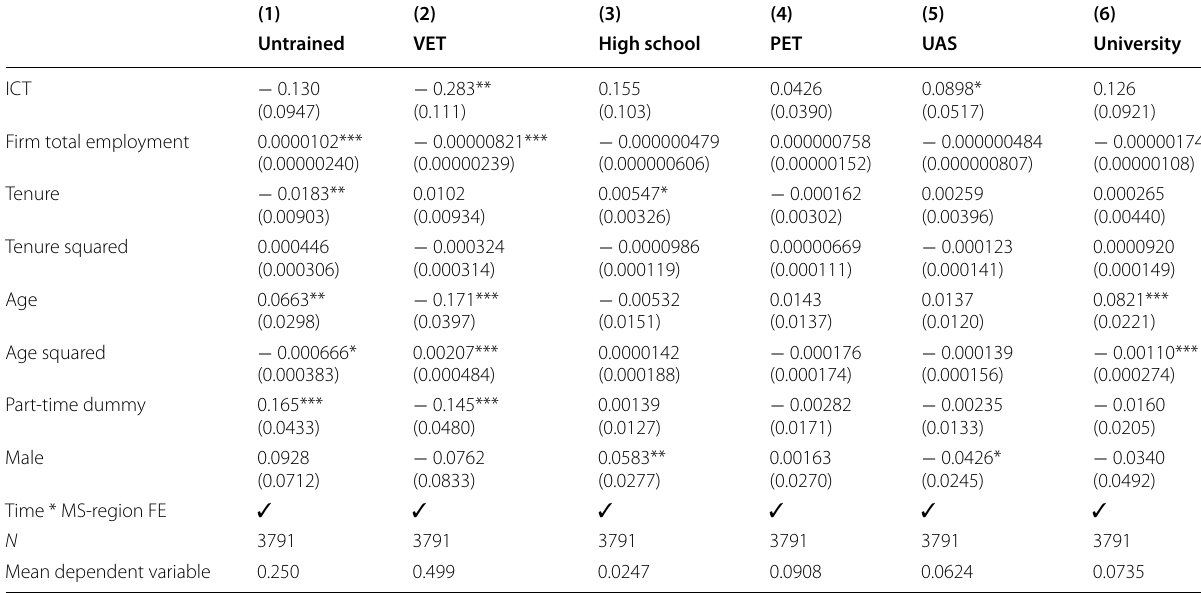
The table shows OLS coefficients of fixed effects estimates of a firm pseudo-panel with cells defined based on MS-region, industry, and firm size. Standard errors in parentheses are clustered at the cell level. N reports the number of pseudo-panel cells that contain at least one firm. The main explanatory variable measures the cell percentage of ICT workers according to ICT tasks (1996–2010) or ICT occupations (2012–2018). Estimates further control for time*MS-region fixed effects and cell averages of total employment, tenure, age, part-time status, and gender. Each column shows the results for a different dependent variable measuring the